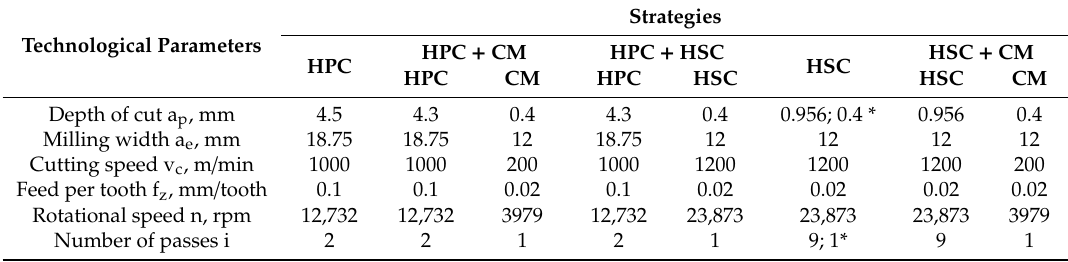
Table 3. Technological parameters corresponding to individual milling strategies.